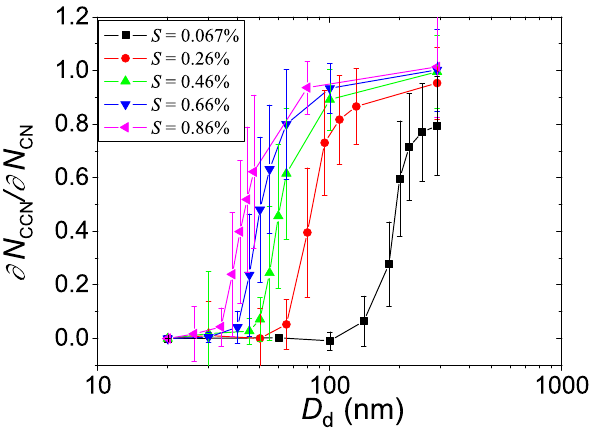
Fig. 7. Average CCN efficiency spectra for the CAREBeijing-2006 campaign (10 August to 8 September 2006, Yufa, Beijing, China). The data points and error bars represent arithmetic mean values ± one standard deviation. Note that the experimental uncertainties ( < 10%, Rose et al., 2010a) were smaller than the temporal variability of the measurement data as indicated by the error bars.